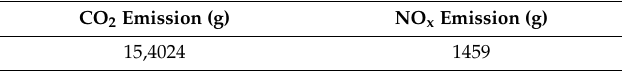
Table 5. Total emissions under actual vehicle speed.